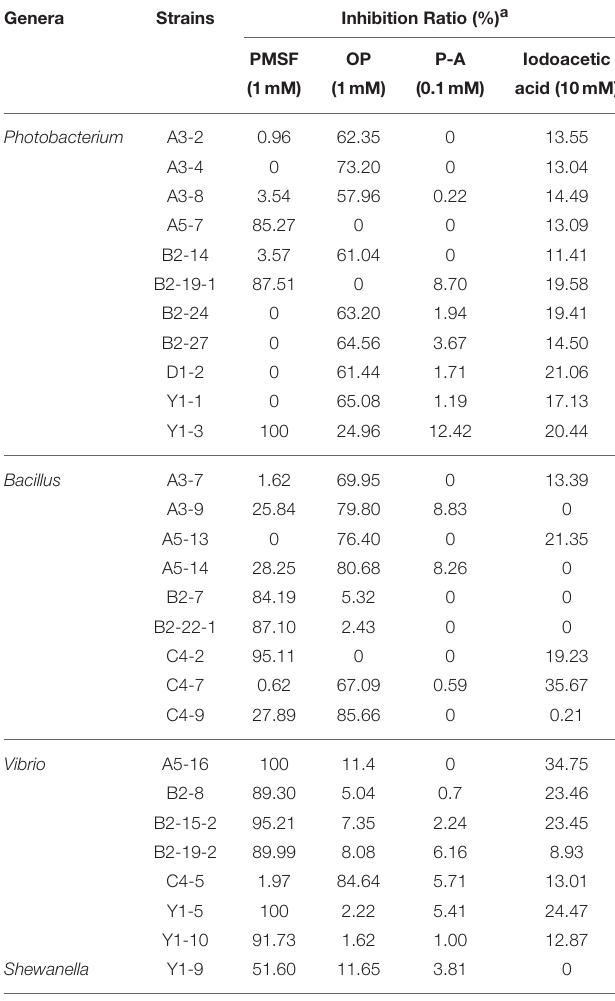
TABLE 2 | Effects of inhibitors on the extracellular proteases secreted by strains from Jiaozhou Bay sediments. Genera Strains Inhibition Ratio (%) a